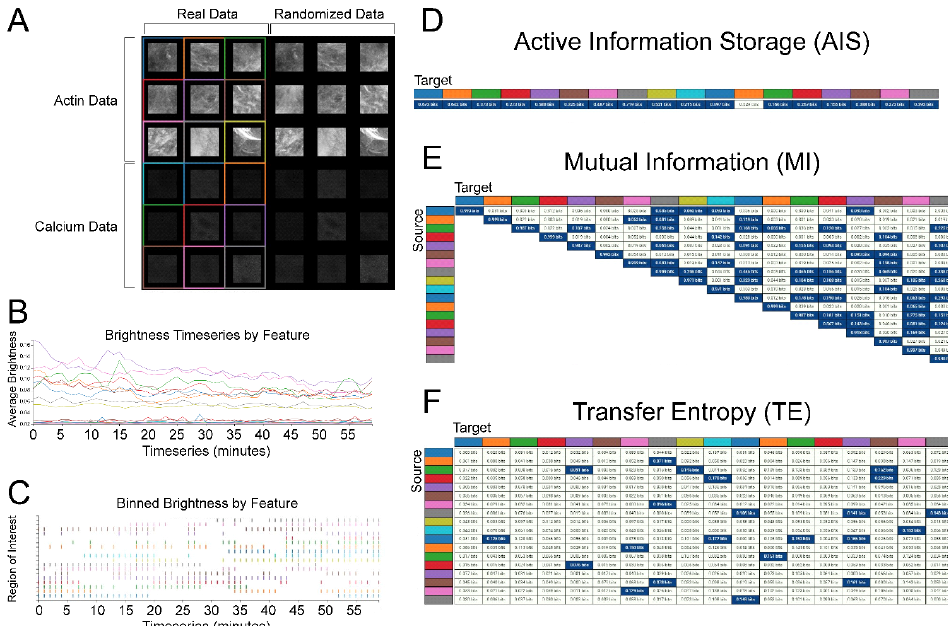
Figure 8. CAIM: A tool for applying information theory metrics to time series data: ( A ) CAIM provides users a GUI to select regions of interest (demarcated by consistent colors throughout the analysis) from which it will extract timeseries data ( B ) that can then be binarized ( C ); ( D – F ) then AIS, ME, and TE, respectively, can be calculated between each ROI and displayed in tables with statistically significant values indicated in blue.